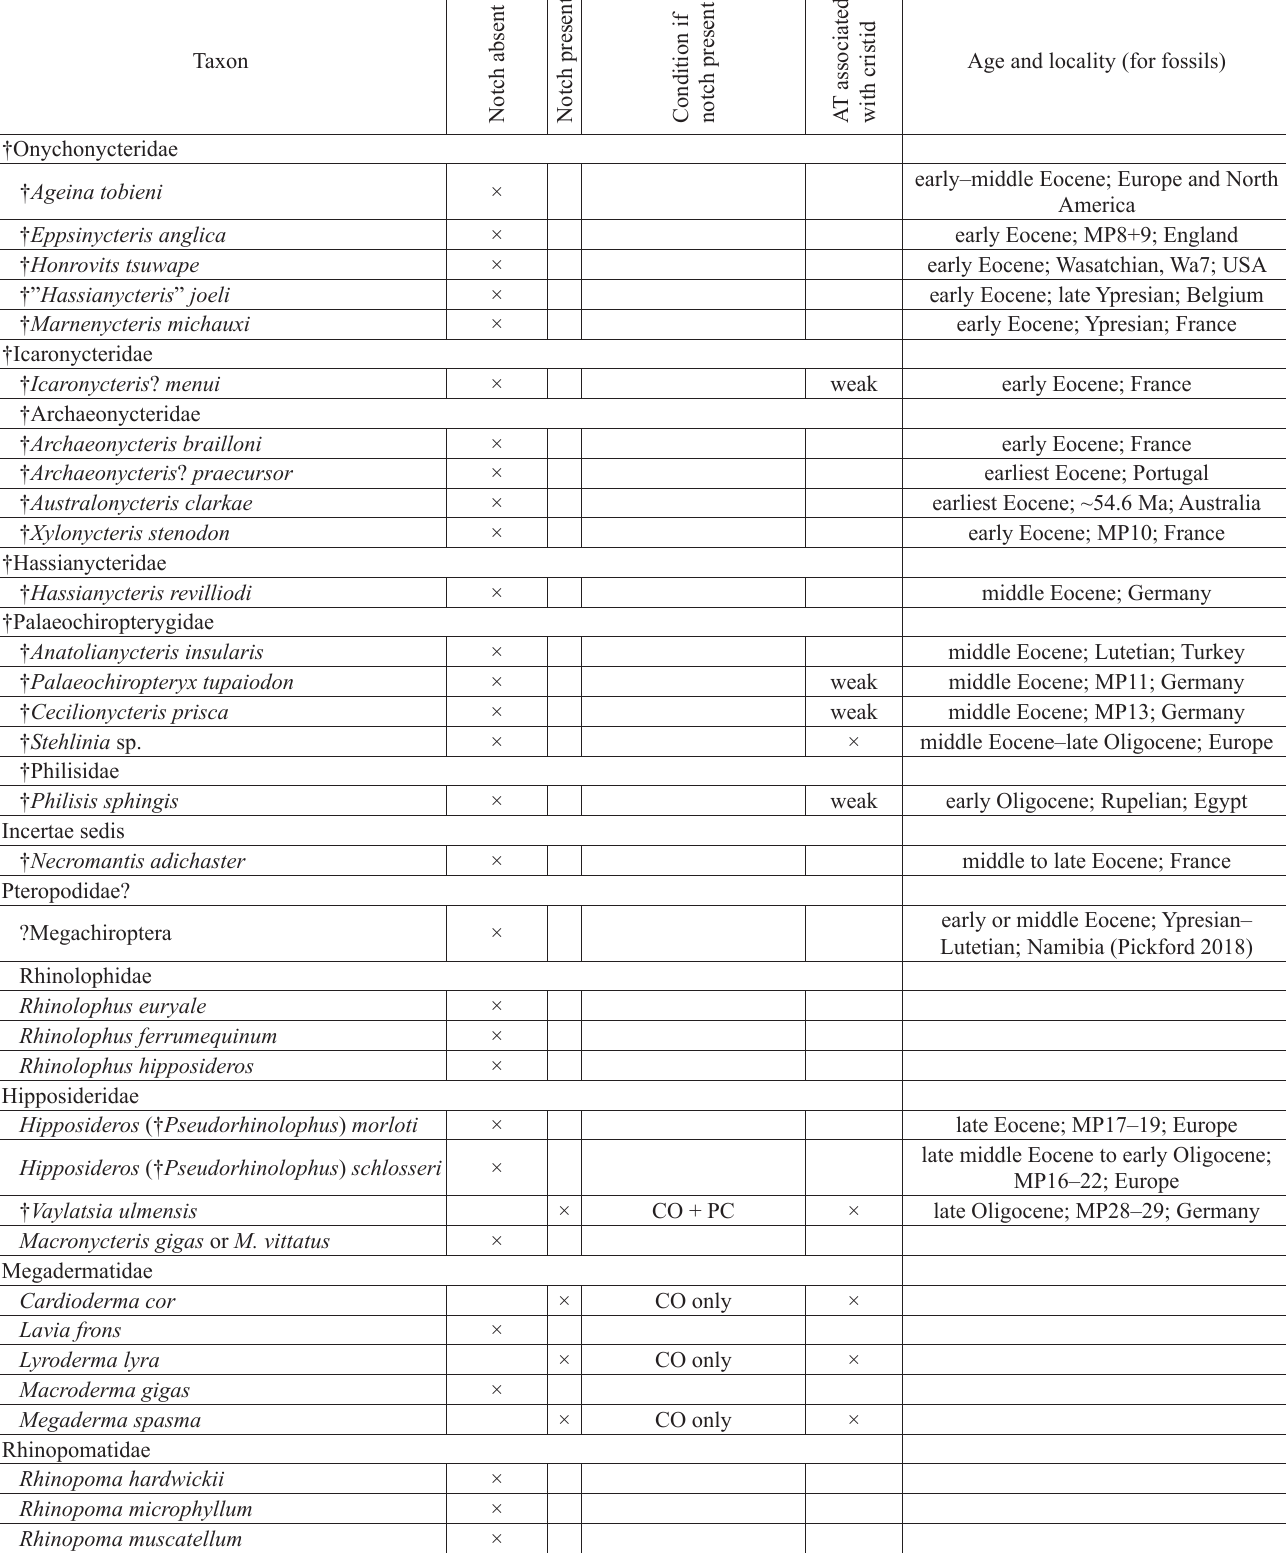
Table 1. List of bat families and species studied and the occurrence among them of carnassiform notches in unworn or little-worn lower molars. † indicates extinct taxa; AT, accessory trough; CO, cristid obliqua; PC, postcristid; “unknown” indicates condition for specimens in which the lower molars were too worn, occluded with debris, or otherwise unsuitable for scoring; “derived”, indicates species whose lower molars are specialized and lack the primitive tribosphenic molar